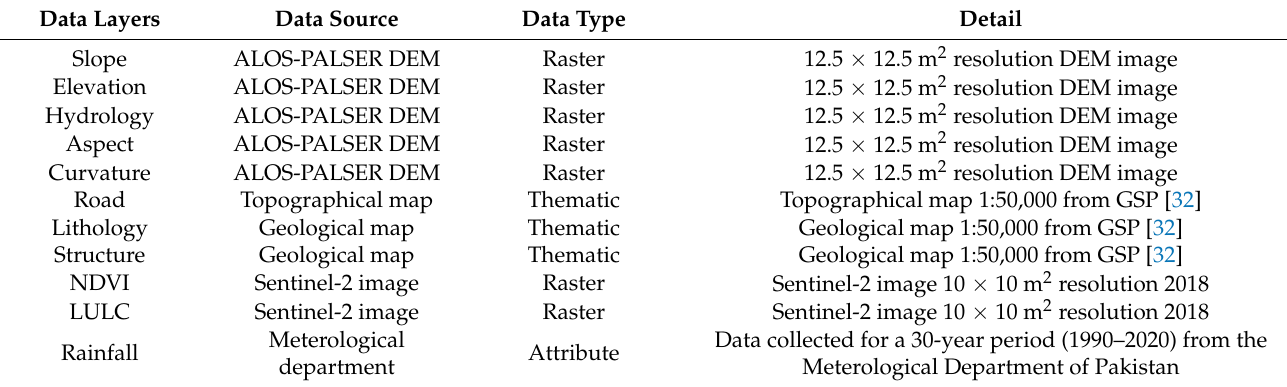
Table 1. Complete details of the data sources and causative